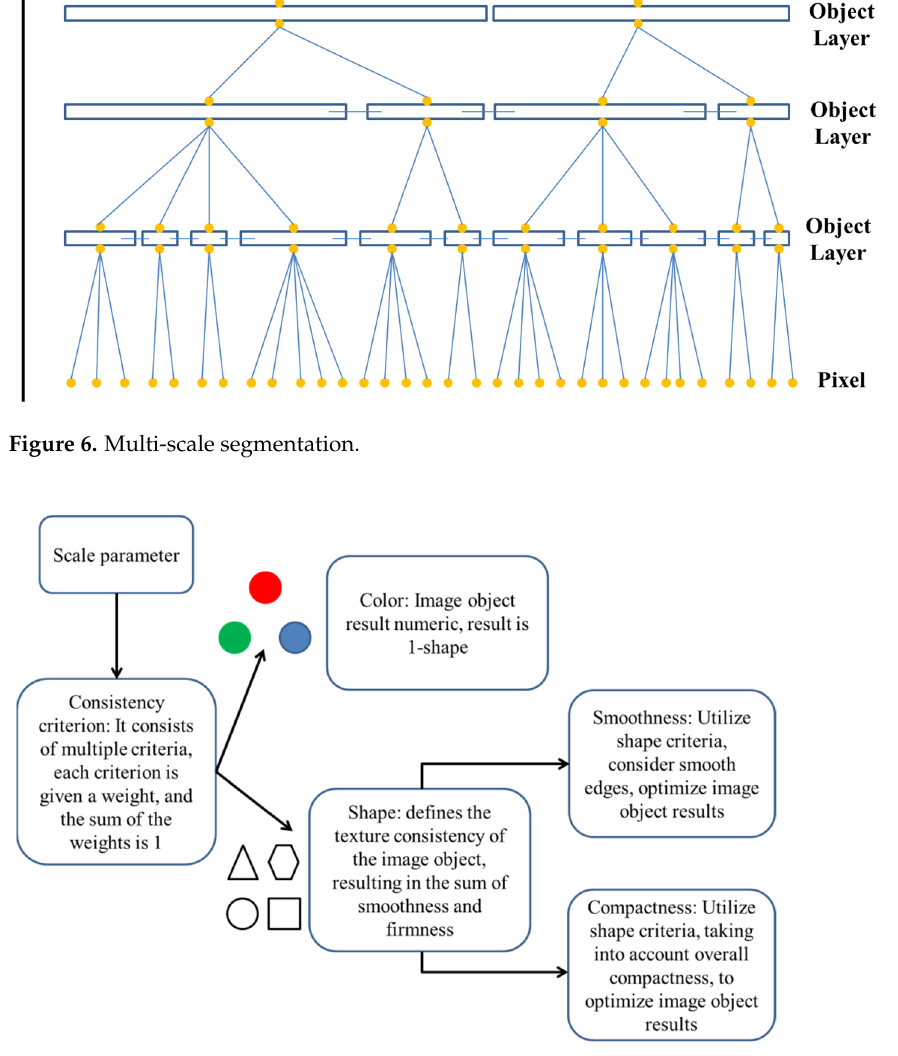
Figure 6. Multi-scale segmentation.